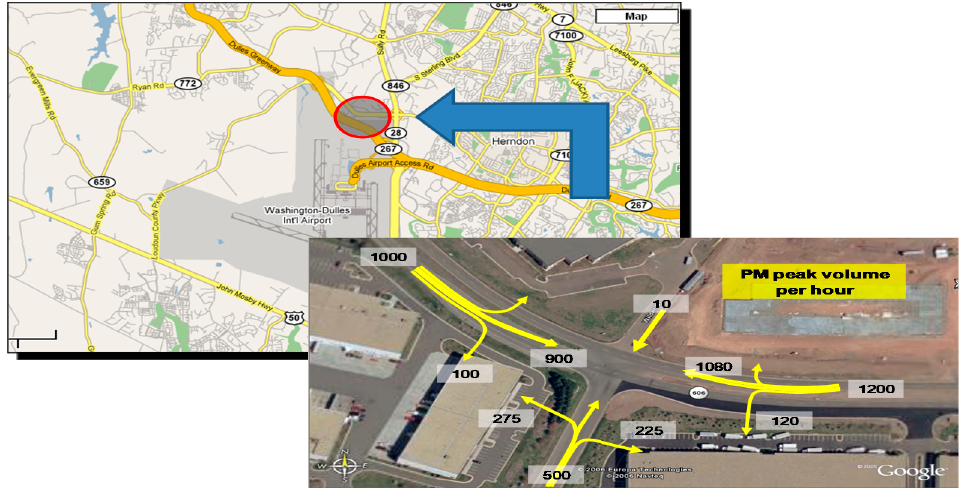
Figure 1. Map and aerial view of the modelled intersection (Source: Google Maps).